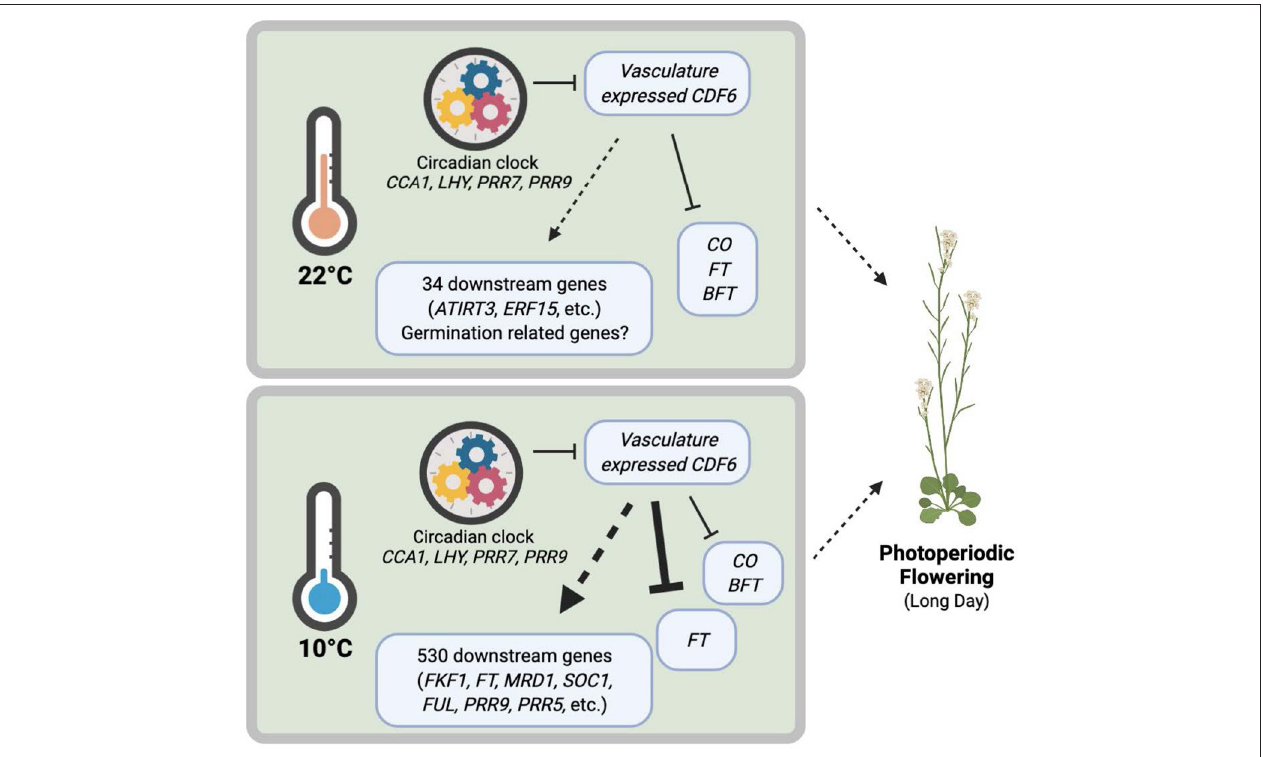
FIGURE 5 | Clock-regulated, cold-induced, and vasculature-expressed CDF6 finetunes plant growth and development under different temperatures. The circadian clock regulates CDF6 transcript accumulation in the vasculature at specific times of the day. During ambient temperature, CDF6 regulates FT, CO, BFT, and at least 34 other downstream genes (16 in cdf6 -WT and 18 in SUC2::CDF6 -WT), including ATIRT3 and ERF15, which contribute to germination and flowering phenotypes. During cold temperatures, CDF6 regulates 530 downstream genes and represses FT, CO, and BFT in the vasculature/phloem companion cells to control photoperiodic flowering. Model created with